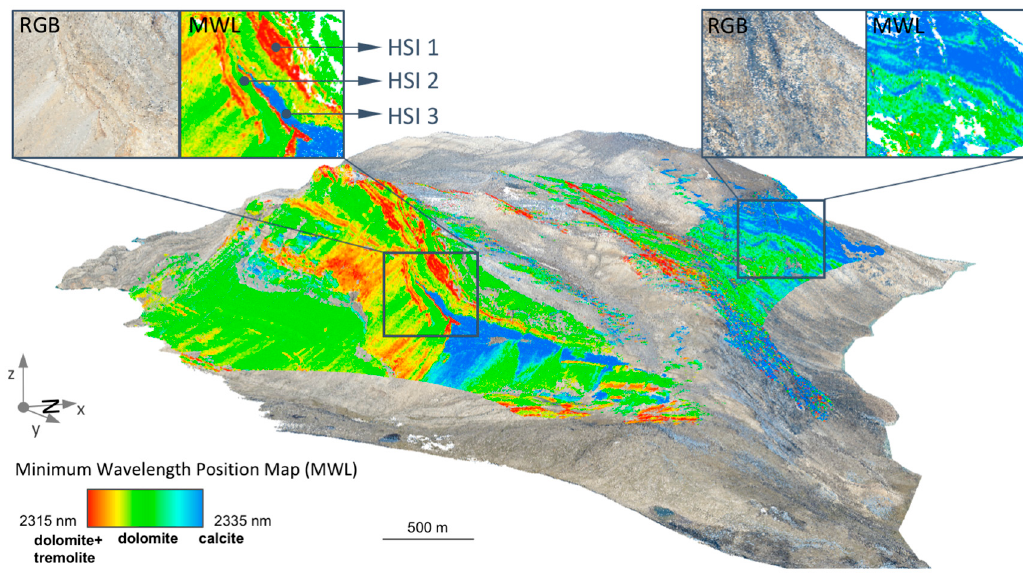
Figure 9. 3D hypercloud of two individual HSI image scenes overlain on photogrammetric RGB point cloud of the Maarmorillik marble cliffs. Minimum Wavelength Position Mapping was applied to both HSI datacubes to highlight variations in carbonate composition. HSI 1, 2, and 3 mark the sampling points of Figure 8.